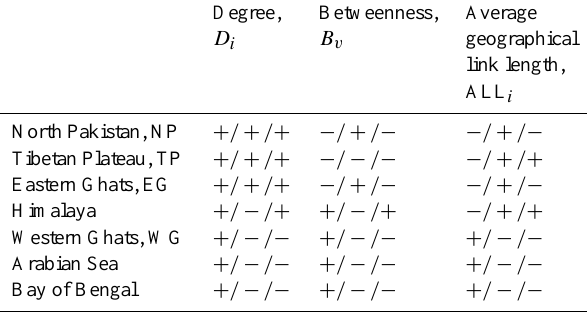
Table 4. Hubs of the extreme rainfall networks. Columns are hubs in degree, betweenness, and average link length. “ + ” – the network measure in the given region is in the top 10% for the given period. “ − ” – lower than the top 10%. The order of “ + ” or “ − ” means the season: pre-monsoon, monsoon, and post-monsoon, respectively. For example, the intersection of first row and first column (North Pakistan (NP) and degree) – “ + / + / + ” – means that one can ob- serve a high degree in NP during the pre-monsoon, monsoon, and post-monsoon seasons,